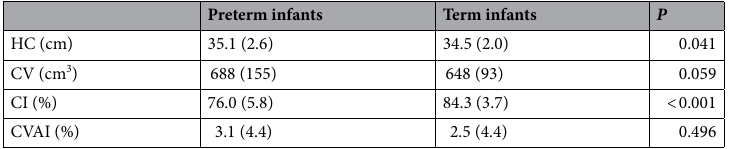
Table 3. Metric and volumetric evaluation of preterm and term infants ‘ heads. HC head circumference; CI cranial index; CV cranial volume, CVAI cranial vault asymmetry index. Data are displayed as median (and interquartile range).